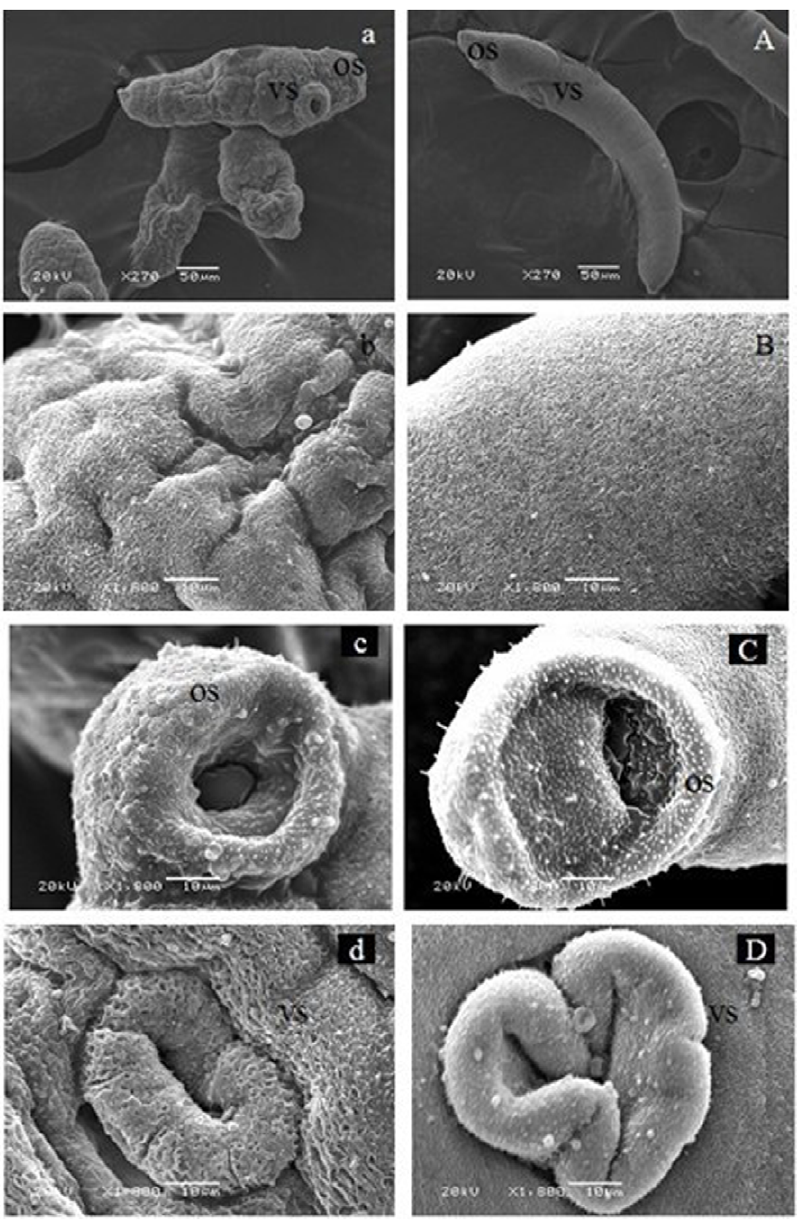
Figure 1. Scanning electron microscopy (SEM) of schistosomula from Microtusfortis (a,b,c,d) and BALB/c mice (A, B, C, and D). Os, oral sucker; Vs, ventral sucker.